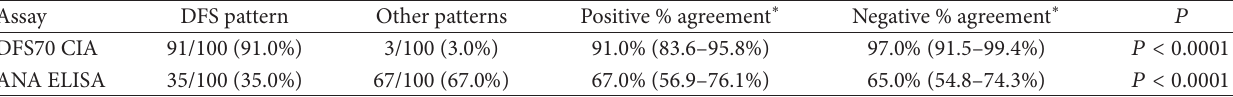
F 3: Discrimination between SARD and non-SARD patients using DFS70 and ANA by ELISA. (a) Differentiation of SARD versus non-SARD in all patients ( ) using DFS70. (b) Differentiation of SARD versus non-SARD in all patients ( ) using ANA Screen ELISA. (c) Differentiation of SARD versus non-SARD in all patients ( ) using ANA Screen ELISA and DFS70 Score (ANA ELISA divided by DFS70 CIA). 𝑛𝑛 𝑛 𝑛𝑛𝑛 𝑛𝑛 𝑛 𝑛𝑛𝑛 𝑛𝑛 𝑛 𝑛𝑛𝑛 T 1: Correlation between DFS and other IIF patterns and anti-DFS70 antibodies by ELISA and CIA.